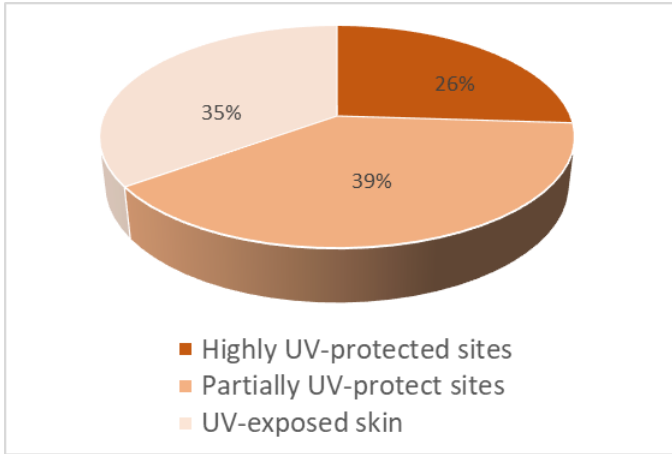
Figure 2. Distribution of primary lesions by their UV exposure. Table 1. Characteristics of the study population.